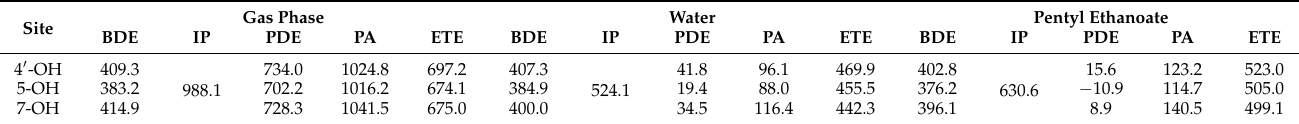
Table 1. Bond dissociation enthalpy (BDE), ionization potential (IP), proton dissociation enthalpy (PDE), proton affinity (PA), and electron transfer enthalpy (ETE) calculated for the molecular form of pelargonidin-3- O -glucoside at M062X/6-31+g(d,p) level in the gas phase, and using SMD solvation models of water and pentyl ethanoate. All values are given in